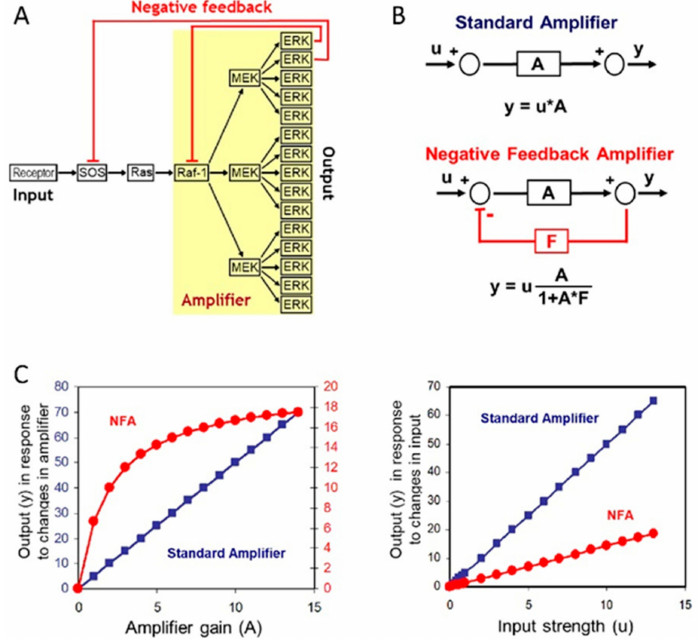
Figure 2. The ERK pathway functions as a negative feedback amplifier (NFA). ( A ) Schematic representation of the ERK pathway with approximate stoichiometries of pathway components typically found in cells and negative feedbacks indicated. ( B ) Comparison of a standard amplifier and